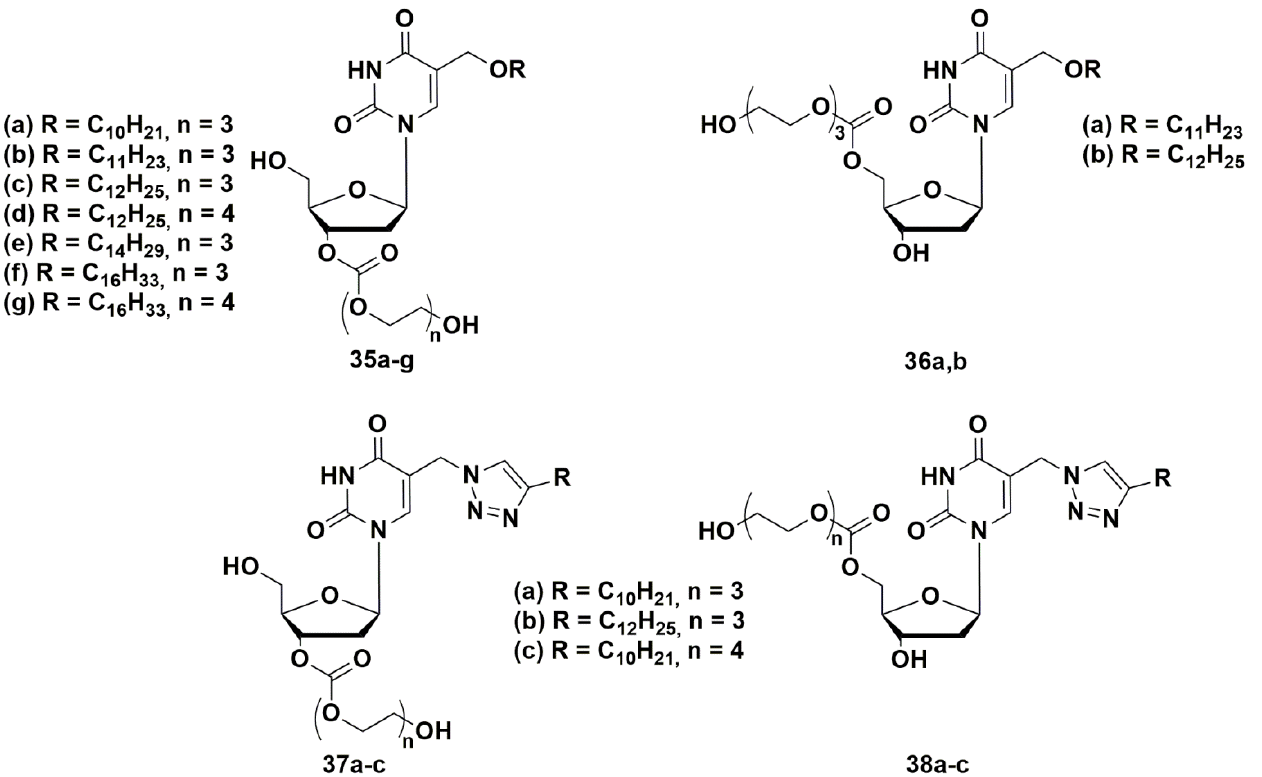
Figure 10. Depot forms of 5-alkyloxymethyl— 35 , 36 и 5-alkyltriazolylmethyl; 37 , 38 2 ′ -deoxyuridines.